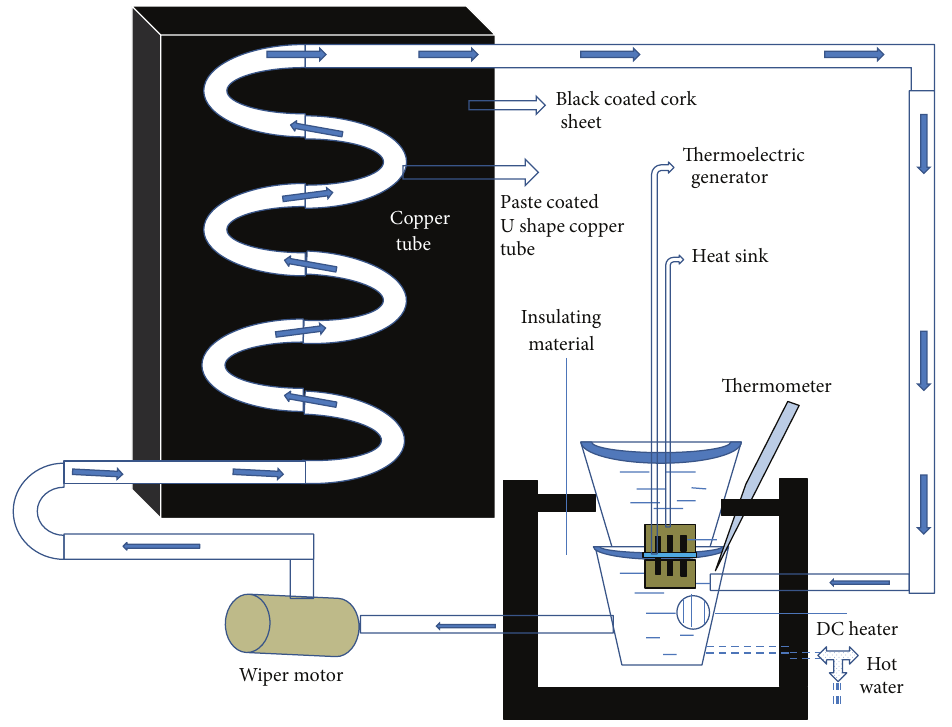
Figure 1: A proposed model of solar water heating